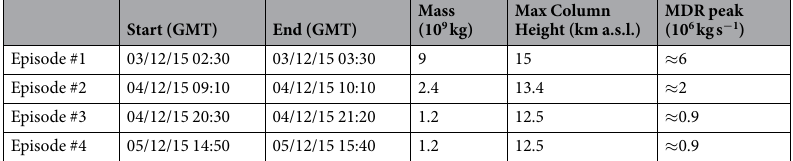
Table 1. Timing and eruptive parameters from 8 .